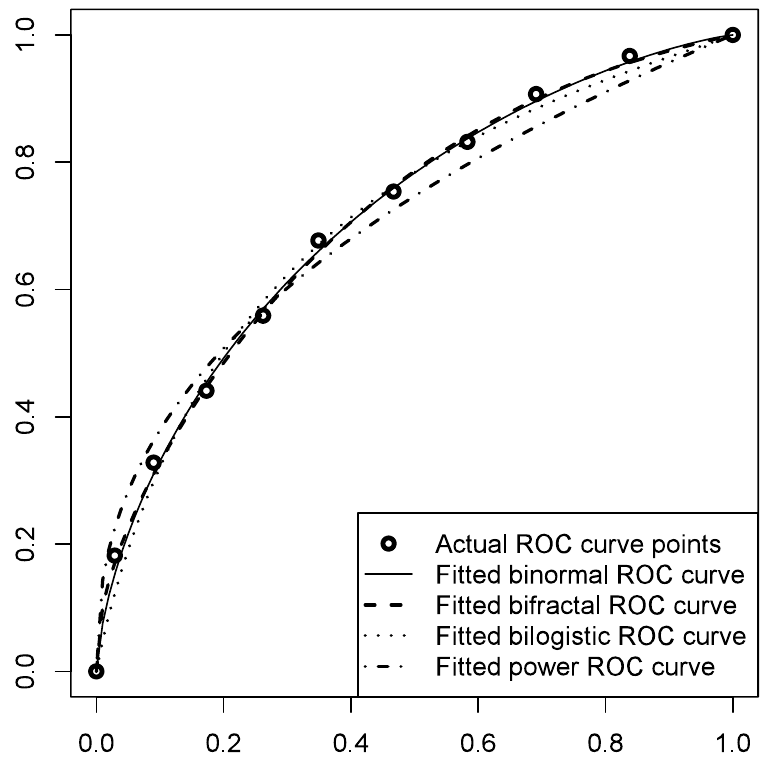
Figure 3. Results of the fitting of ROC models to the D1 data. Table 1. Results of the fitting of four ROC models to the D1 data.